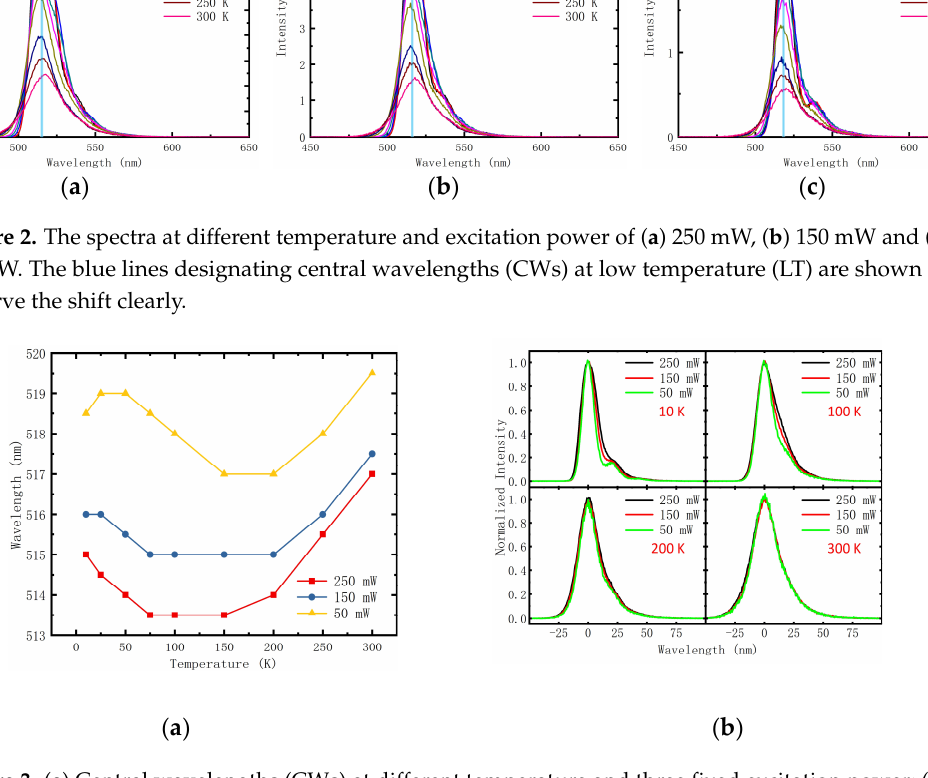
Figure 3. ( a ) Central wavelengths (CWs) at different temperature and three fixed excitation power; ( b ) Spectra at different temperature and three fixed excitation power which are normalized and shifted to a same CW.